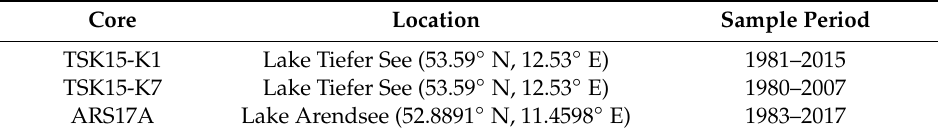
Table 1. Lake surface sediment cores sampled for annual resolution pollen analysis.